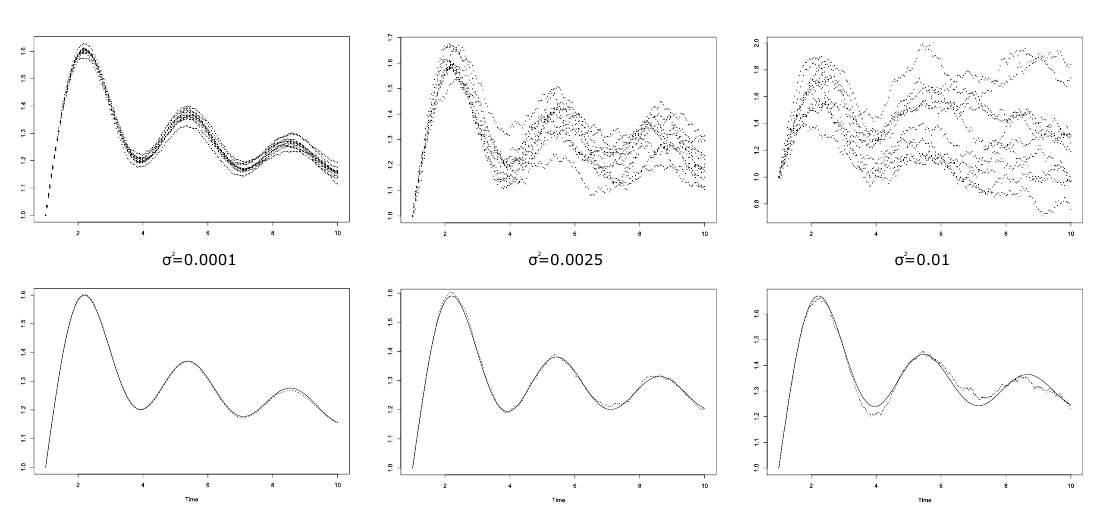
Figure 9. Sample paths (top) and simulated vs. estimated mean functions (bottom) for σ 2 = 0.0001,0.0025,0.01, (see Table